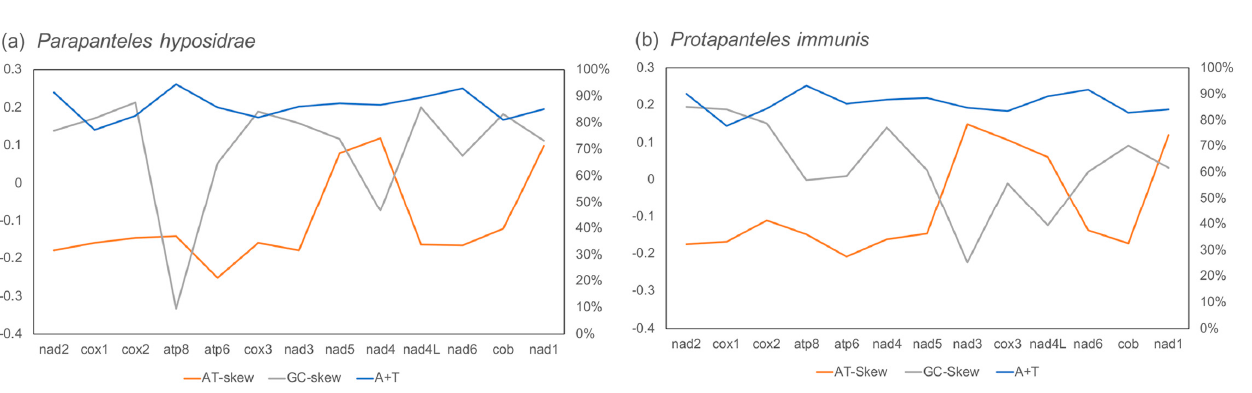
Figure 2. Base composition of protein-coding genes. ( a ) Pa. hypsidrae ; ( b ) Pr. immunis . The relative synonymous codon usage (RSCU) in the mitochondrial genomes of Pa.